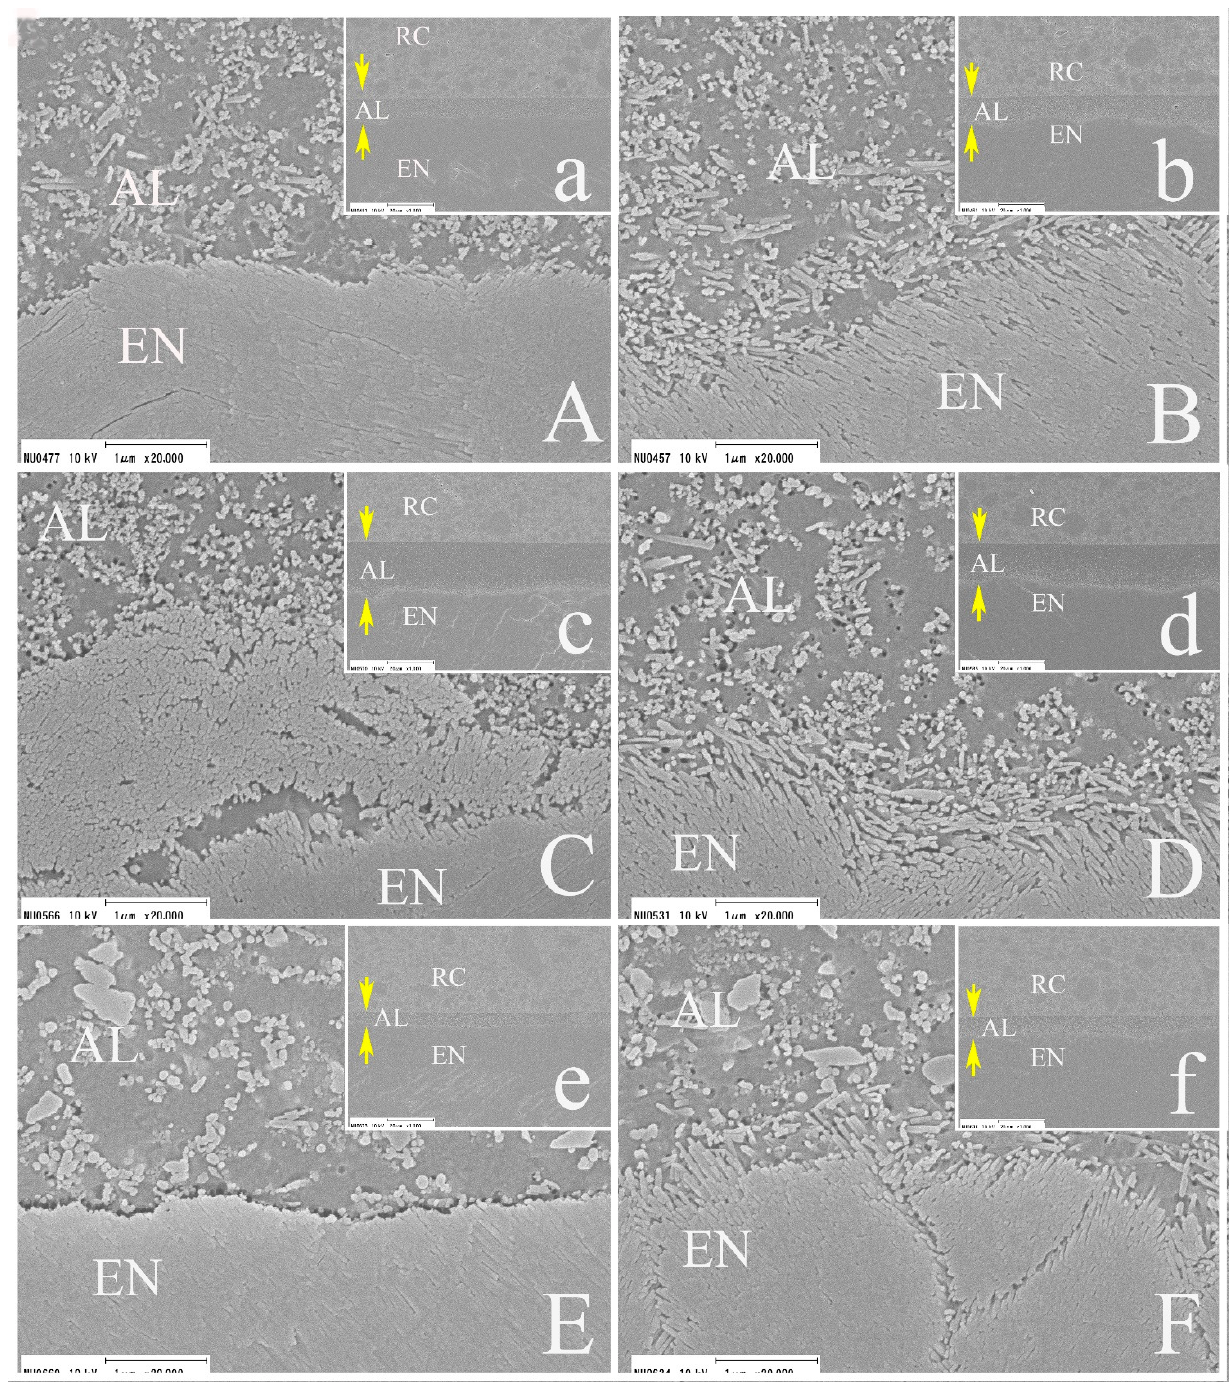
Figure 7. Representative SEM images of resin/enamel interfaces (Group I). ( A ) CS in SE mode ( × 20,000, × 1000). ( B ) CS in ER mode ( × 20,000, × 1000). ( C ) GU in SE mode ( × 20,000, × 1000). ( D ) GU in ER mode ( × 20,000, × 1000). ( E ) OX in SE mode ( × 20,000, × 1000). ( F ) OX in ER mode ( × 20,000, × 1000). AL: adhesive layer, EN: enamel, RC: resin composite. The yellow arrows indicate the adhesive